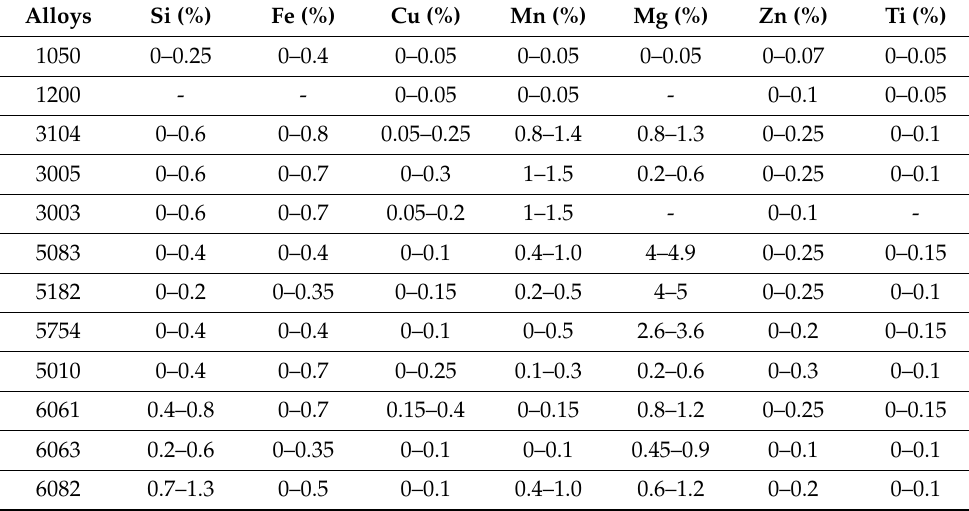
Figure 1. ( a ) Graph showing the consistency of aluminum, ( b ) Graph showing the percentage of each aluminum alloy in the scrap. Table 1. Chemical composition of each alloy in scrap [10,11].